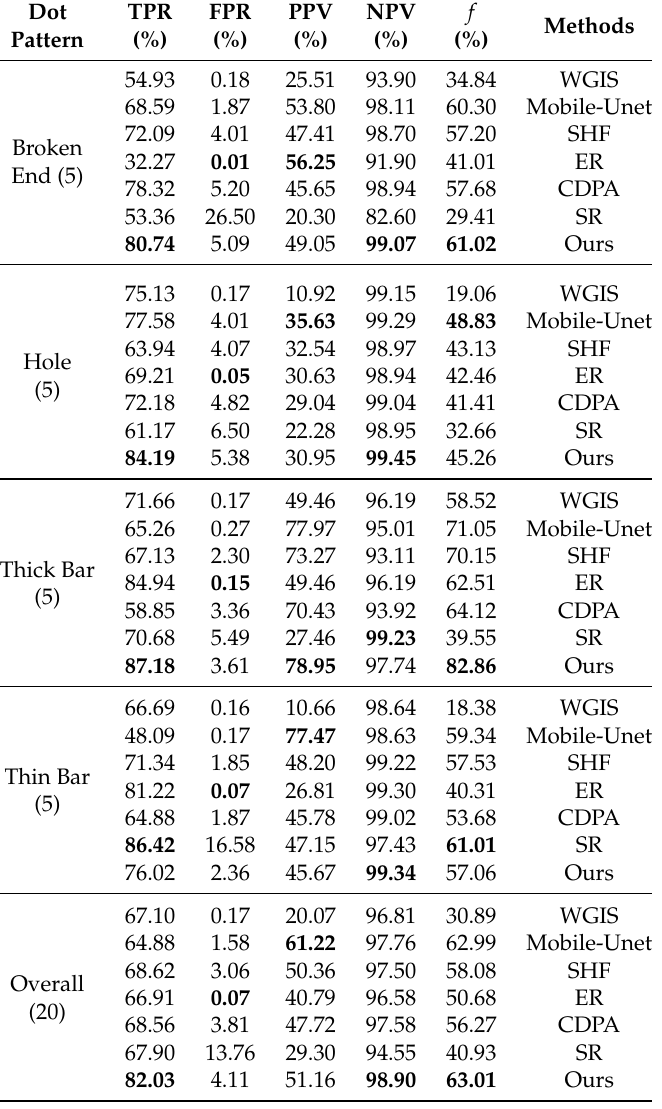
Table 3. Numerical results of each defect type for dot-patterned